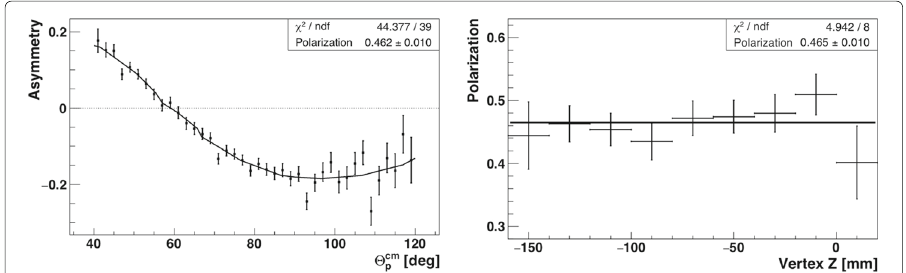
Fig. 20 Left: Experimental asymmetry in pd elastic scattering as a function of proton polar angle in the cm. The curve shows interpolated A d y data from Ref. [24], scaled to fit our data. Right: Target polarization Q estimated as a function of the longitudinal vertex coordinate Z along the storage cell. The straight line represents a fit with a constant scaled with the sought-for value of the target polarization to fit our